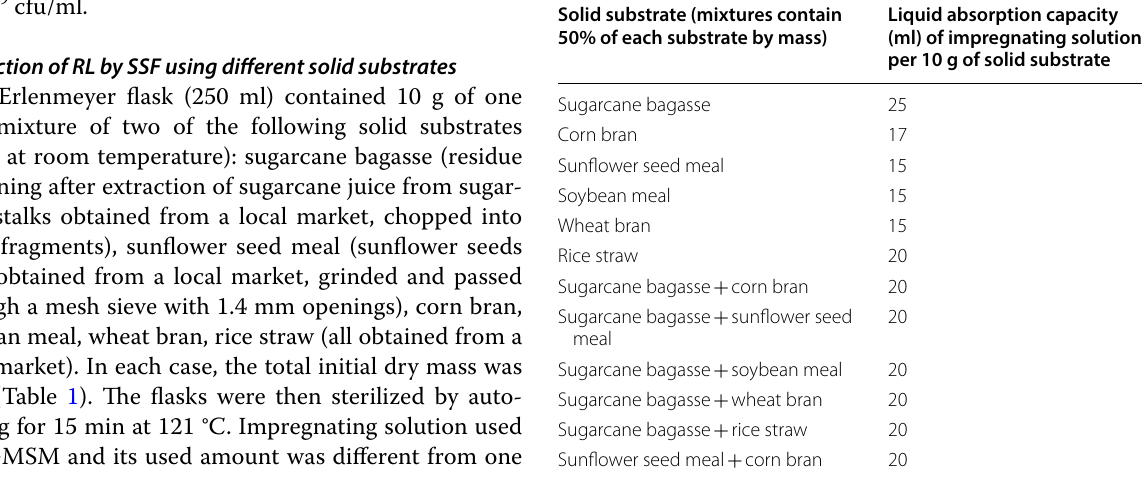
absorption capacity (ml) of impregnating